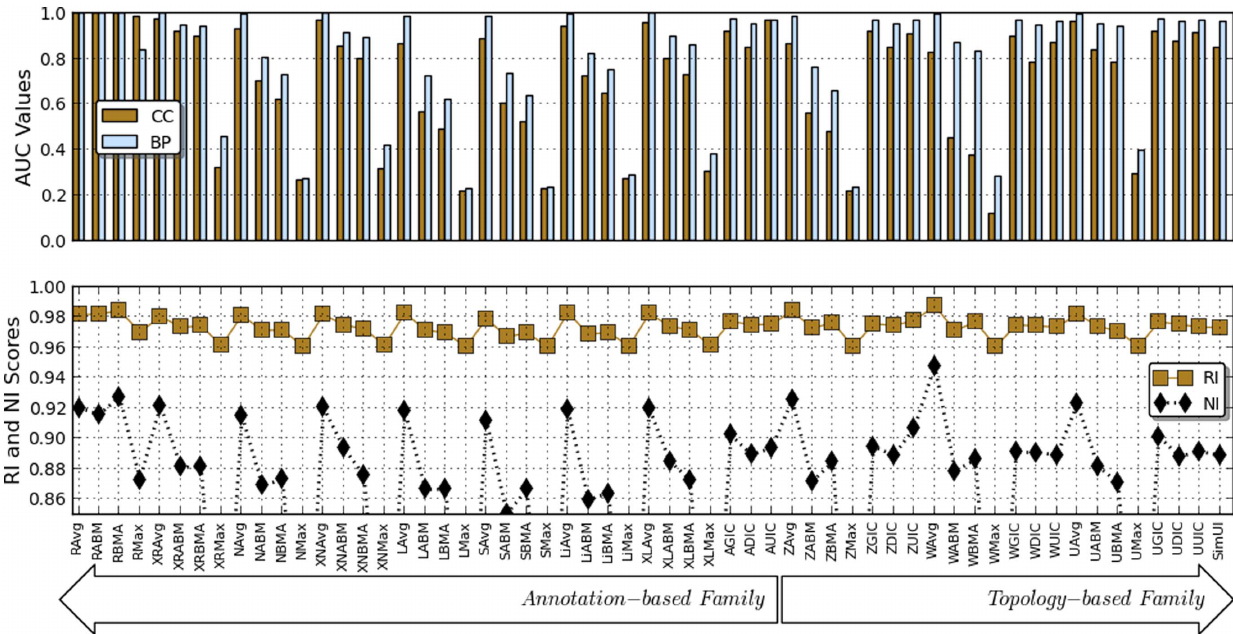
Figure 2. Performance evaluation in terms of clustering power (RI and NI) and Area Under the Curve (AUC) values. Different x-axis labels are the same as in Fig. 1, where different prefixes and suffixes stand for different term semantic similarity approaches and functional similarity